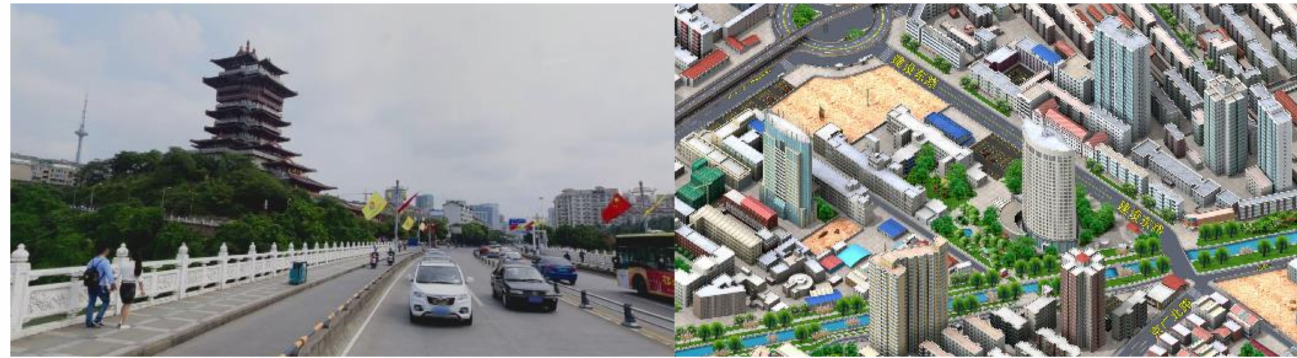
Figure 1. An example picture showing two different types of 3D scene maps (perspective projection in left , orthographic projection in right ).